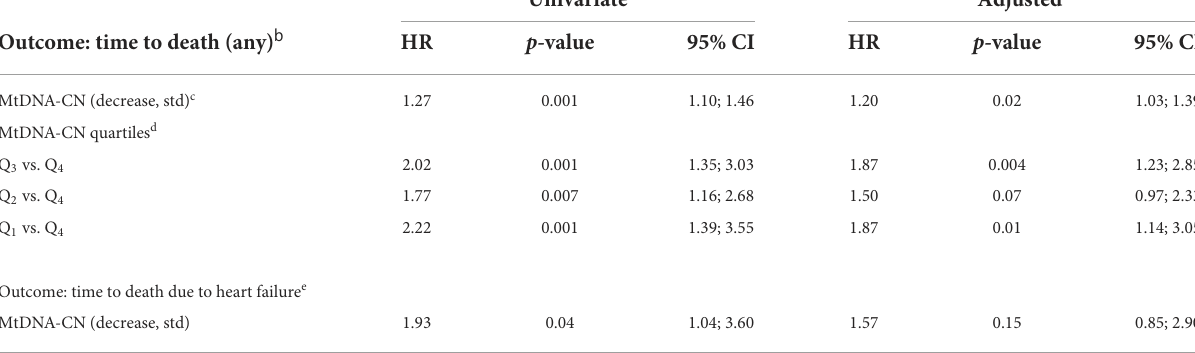
TABLE 5 Cox regression models examining effect of mtDNA-CN on overall mortality and mortality due to heart